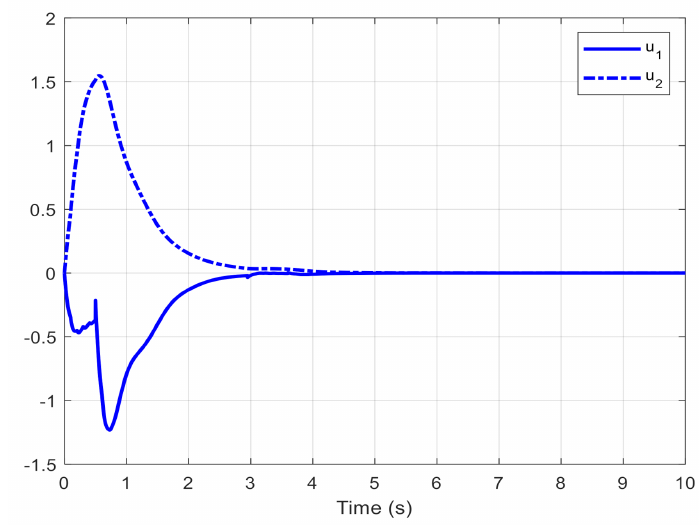
Figure 11. Output observer-based control